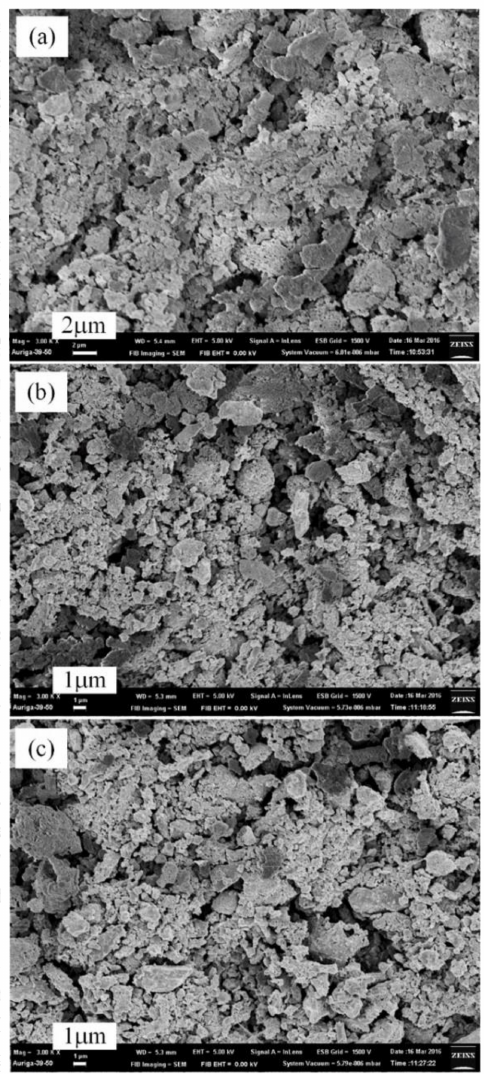
Figure 8. SEM micrographs of powders synthesized by plasma nitridation-thermal nitridation